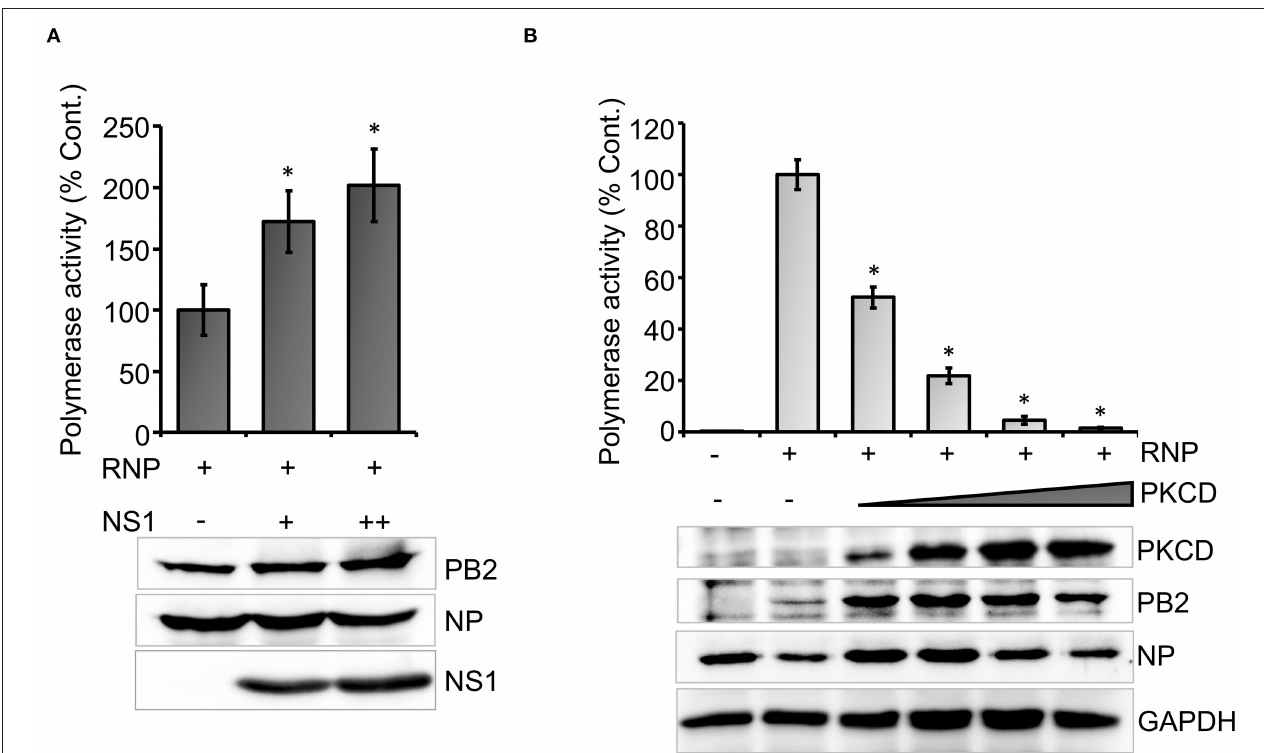
FIGURE 4 | An effect of host and viral factors upon viral RNA synthesis: (A) effect of an increasing amount of viral NS1 protein on influenza B RNP activity assay and (B) effect of an increasing amount of constitutively active host protein kinase C delta (PKCD) protein on B RNP activity assay ( n = 3 ± SD. * p < 0.05 one-way ANOVA with post-hoc student’s t -test when compared to the preceding